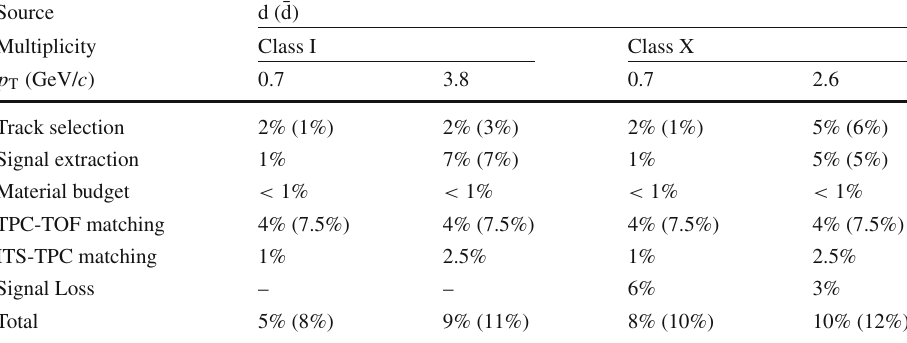
Table 2 Summary of the main contributions to the systematic uncertainties for the extreme multiplicity classes I and